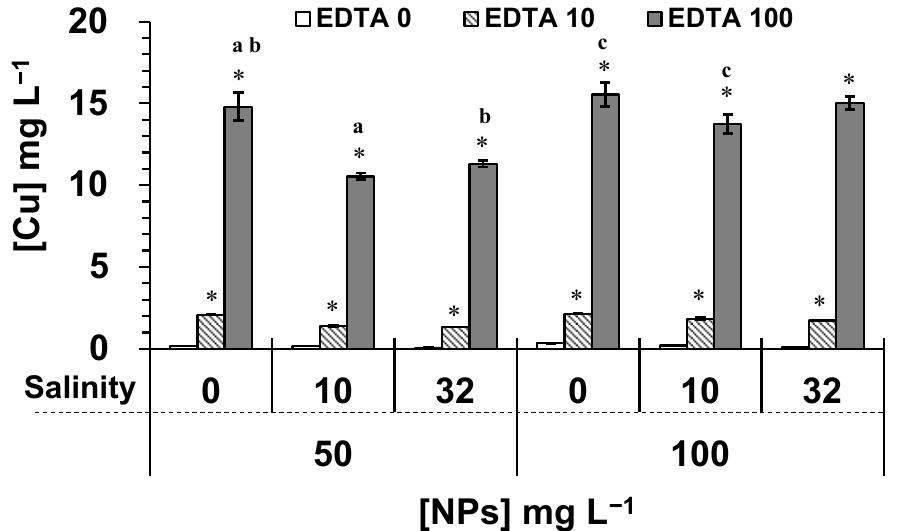
Figure 3. Solubility of CuO-NPs (50 and 100 mg L − 1 ) in HSM (no salt added), and under two salinity conditions, 10 g L − 1 and 32 g L − 1 . NPs were exposed to EDTA concentrations: 0 (white), 10 mg L − 1 (dash), and 100 mg L − 1 (gray). (*) The EDTA effect on NPs significantly caused an increase ( p < 0.05) in the concentration of free Cu compared to respective controls (no EDTA). Moreover, the same letters (a, b, or c) indicated a significant difference for p < 0.05 (determined by one-way ANOVA and Tukey post-hoc test).